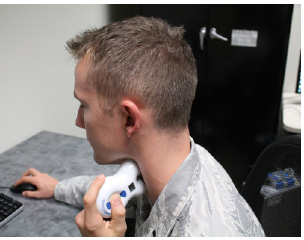
Fig. 5 gammaCore ® Device-use demonstration. An airmen demonstrating the use of the gammaCore ® ctVNS device.